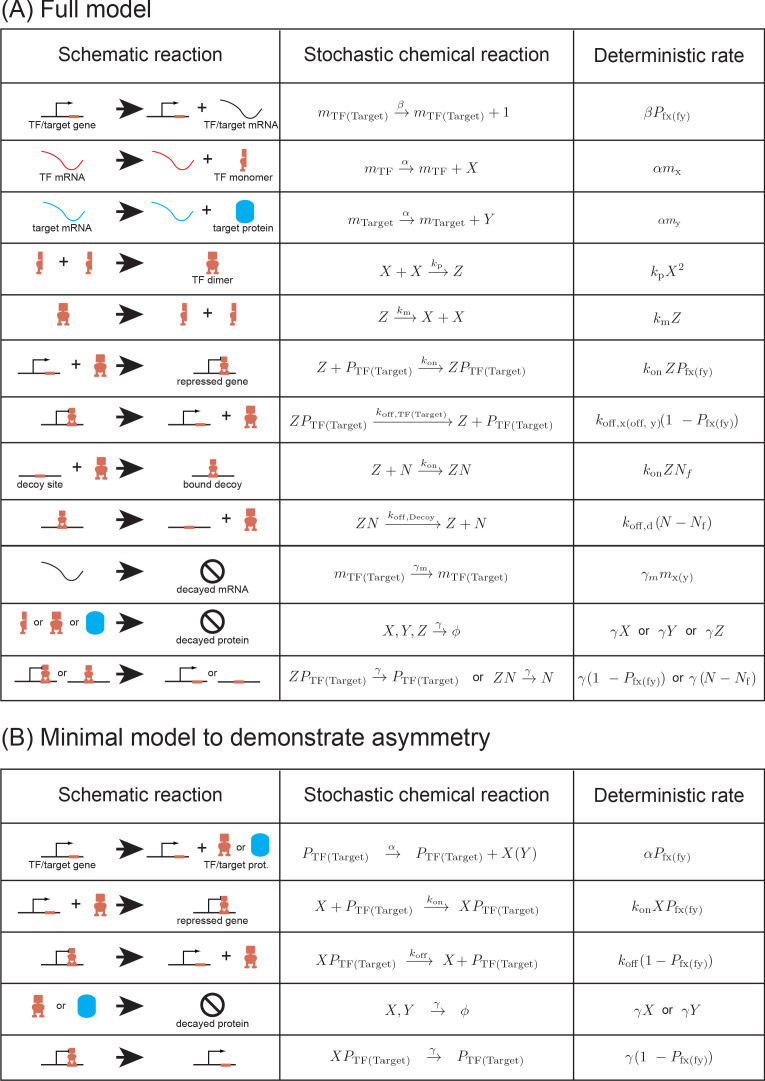
List of reactions used in the (A) stochastic model and (B) in the minimal model.